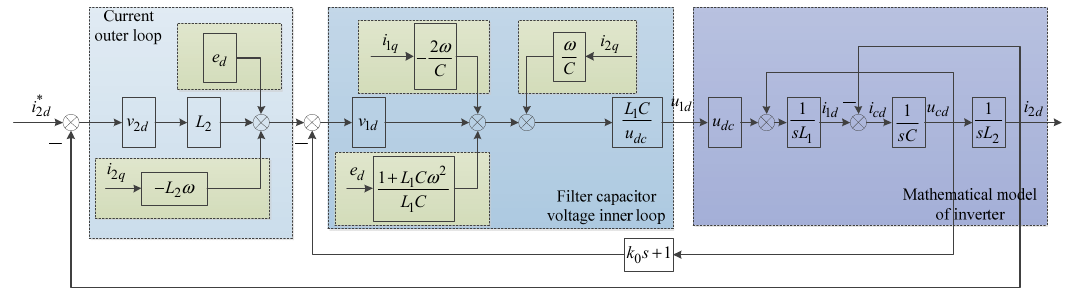
Figure 3. Block diagram of the reduced order feedback decoupling control system.